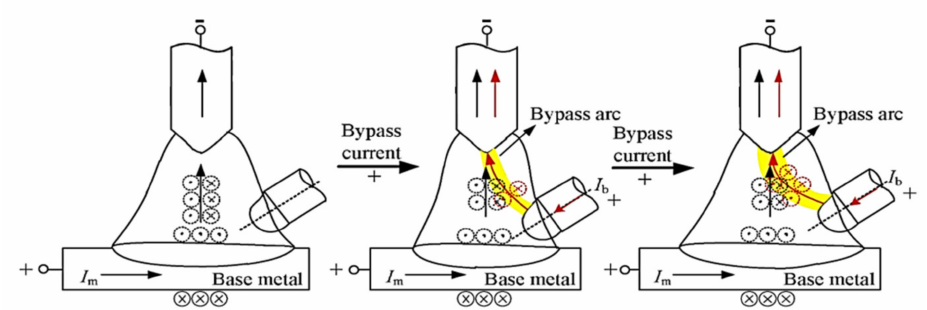
Figure 10. Effect of bypass current on the arc shape. Reprinted from Ref. [27].